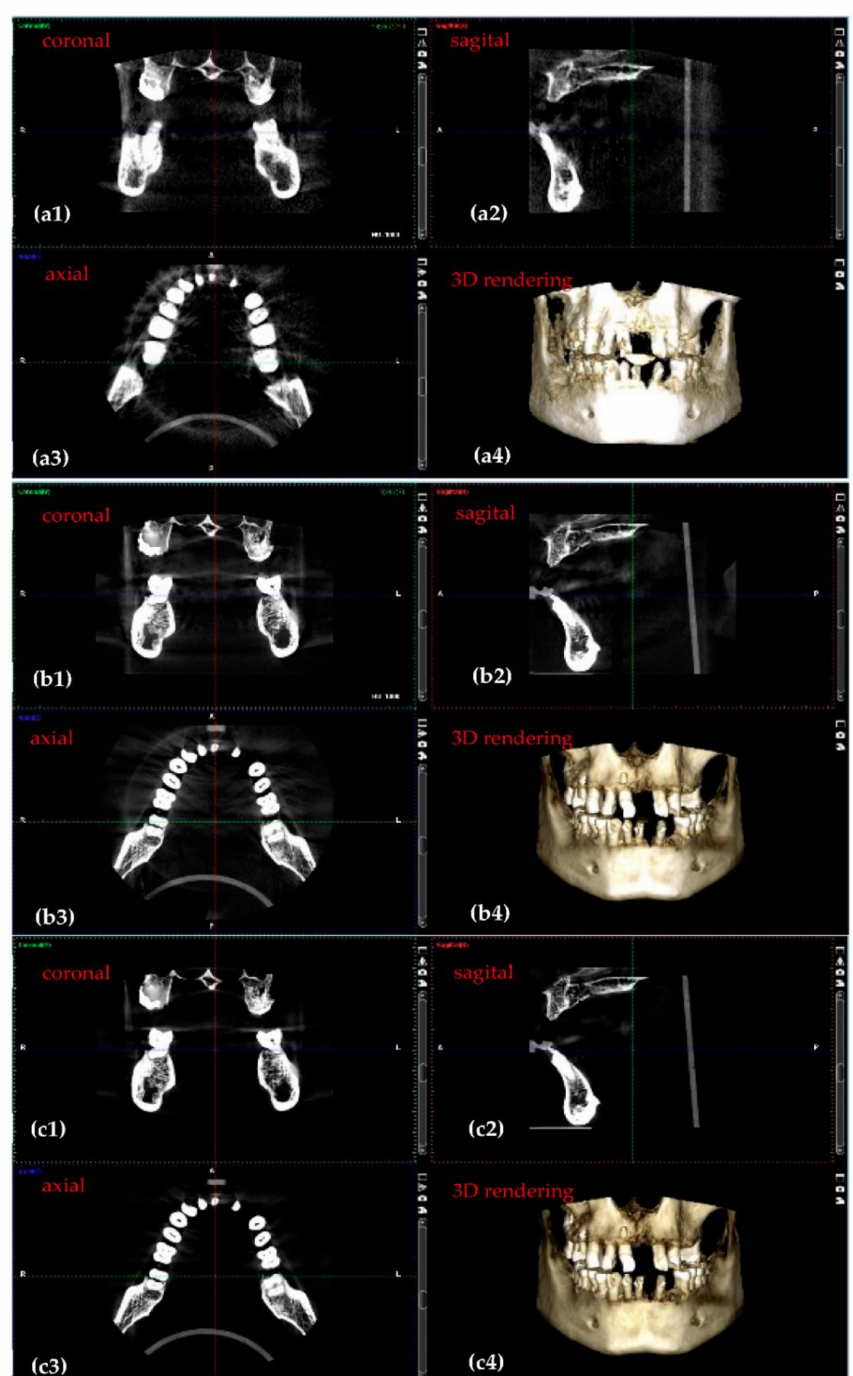
Figure 9. 3D CBCT images obtained through the optimization process. The steps of this process include: ( a ) first 3D CBCT images with the smallest voltage and current values ( b ) an intermediary 3D CBCT; ( c ) the most high-quality 3D CBCT obtained. The four corresponding images in each panel represent: ( 1 ) coronal view; ( 2 ) sagittal view; ( 3 ) axial view; ( 4 ) 3D